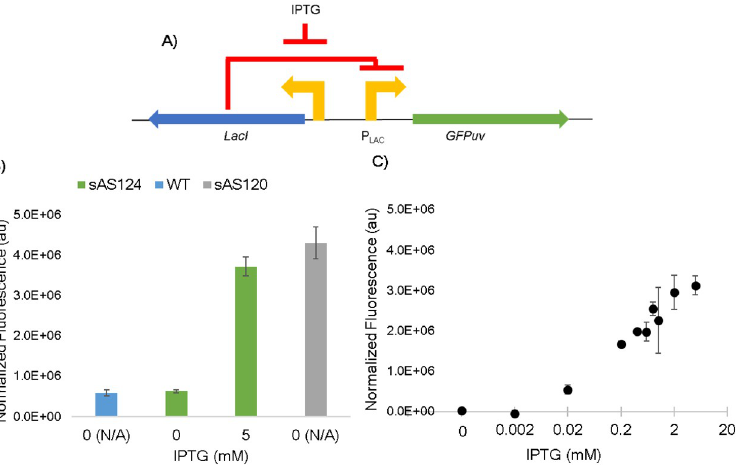
Fig 3. Characterization of strain sAS124 containing SSBIO-AS003 using GFPuv as the reporter protein. (A) Schematic of the expression system used in SSBIO-AS003. (B) Comparison of on and off states of sAS124 at 0 and 5 mM IPTG with wild type A . succinogenes and strain sAS120. Values are normalized by absorbance (Materials and Methods). (C) Induction of sAS124 at IPTG levels ranging from 0 to 5 mM. Values are normalized by absorbance and wild-type (Materials and Methods). All error bars represent one standard